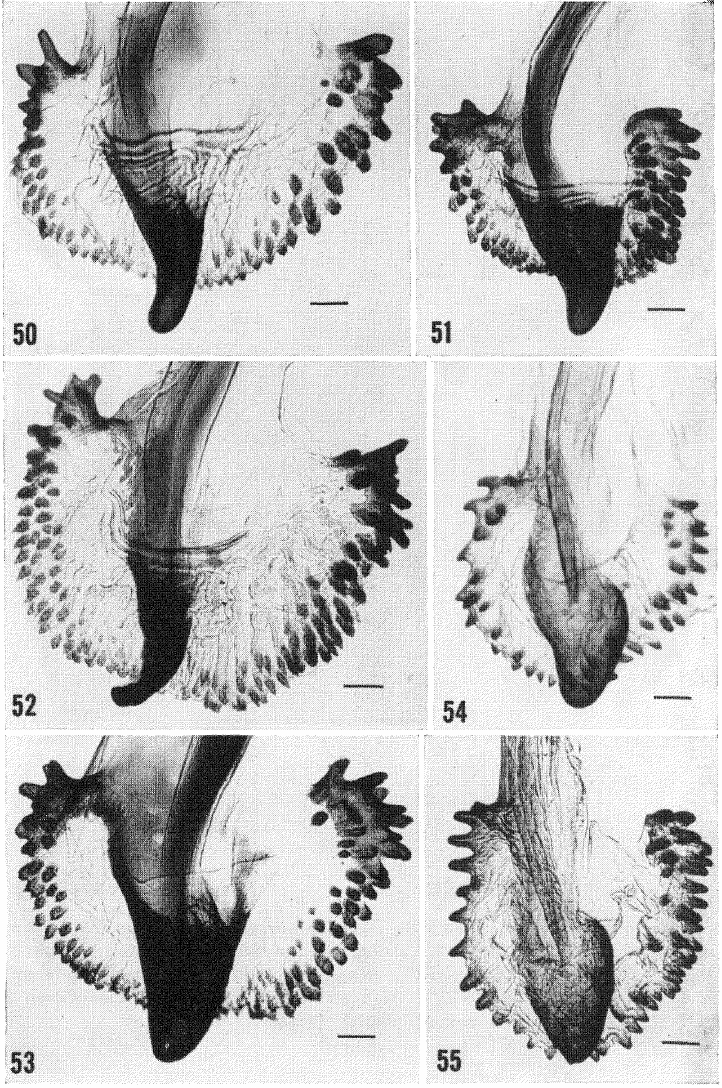
Figs. 50-55. 50. (19 ANSP). Blaberus brasilianus. (from specimen shown in Fig. 10). 51. (62 ANSP). Blaberus minor. Paraguay. 52. (23 ANSP). Blaberus scutatus. (from specimen shown in Fig. 11). 53. (56 ANSP). Blaberus ]usiformis. Provineia Sara, Dept. Vera Cruz, Bolivia. 54-55. Blaberus colosseus. 54. (1 USNM). Trinidad (det. Roth). 55. (30 ANSP). Caparo, Trinidad (det. Hebard). (scale 0.3